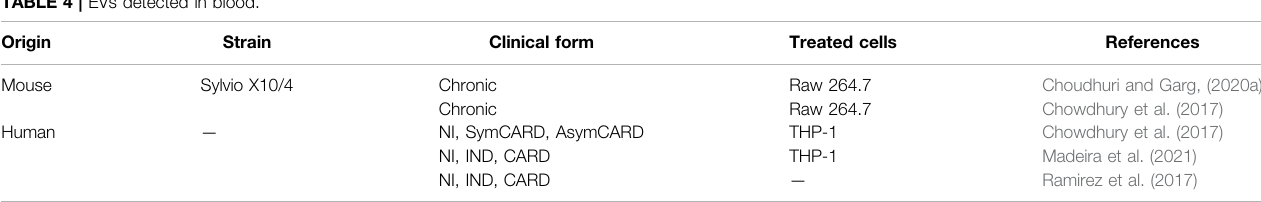
TABLE 4 | EVs detected in